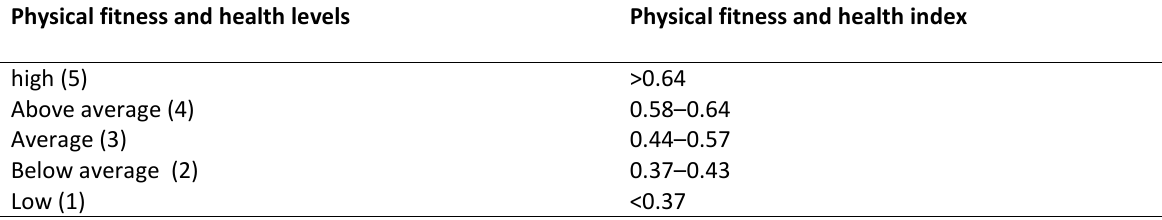
Table 1. Graduation of pupils’ physical fitness and health